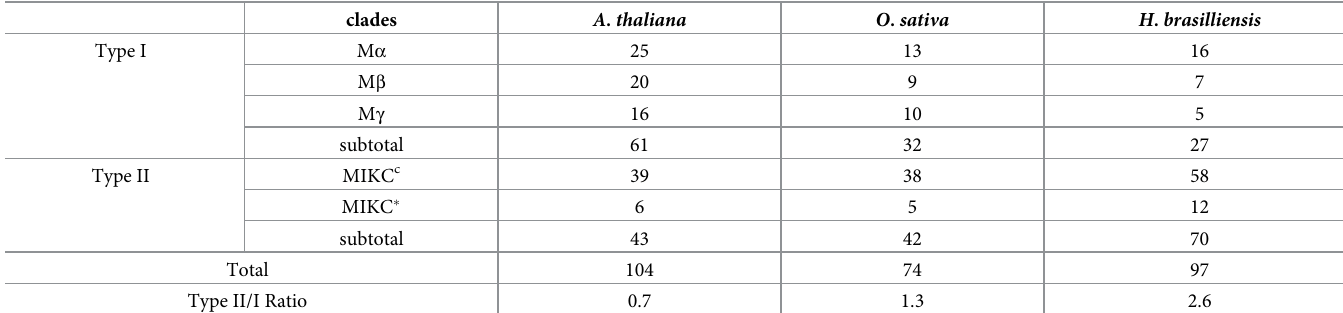
Table 1. Number of annotated MADS-box genes present in genomes.